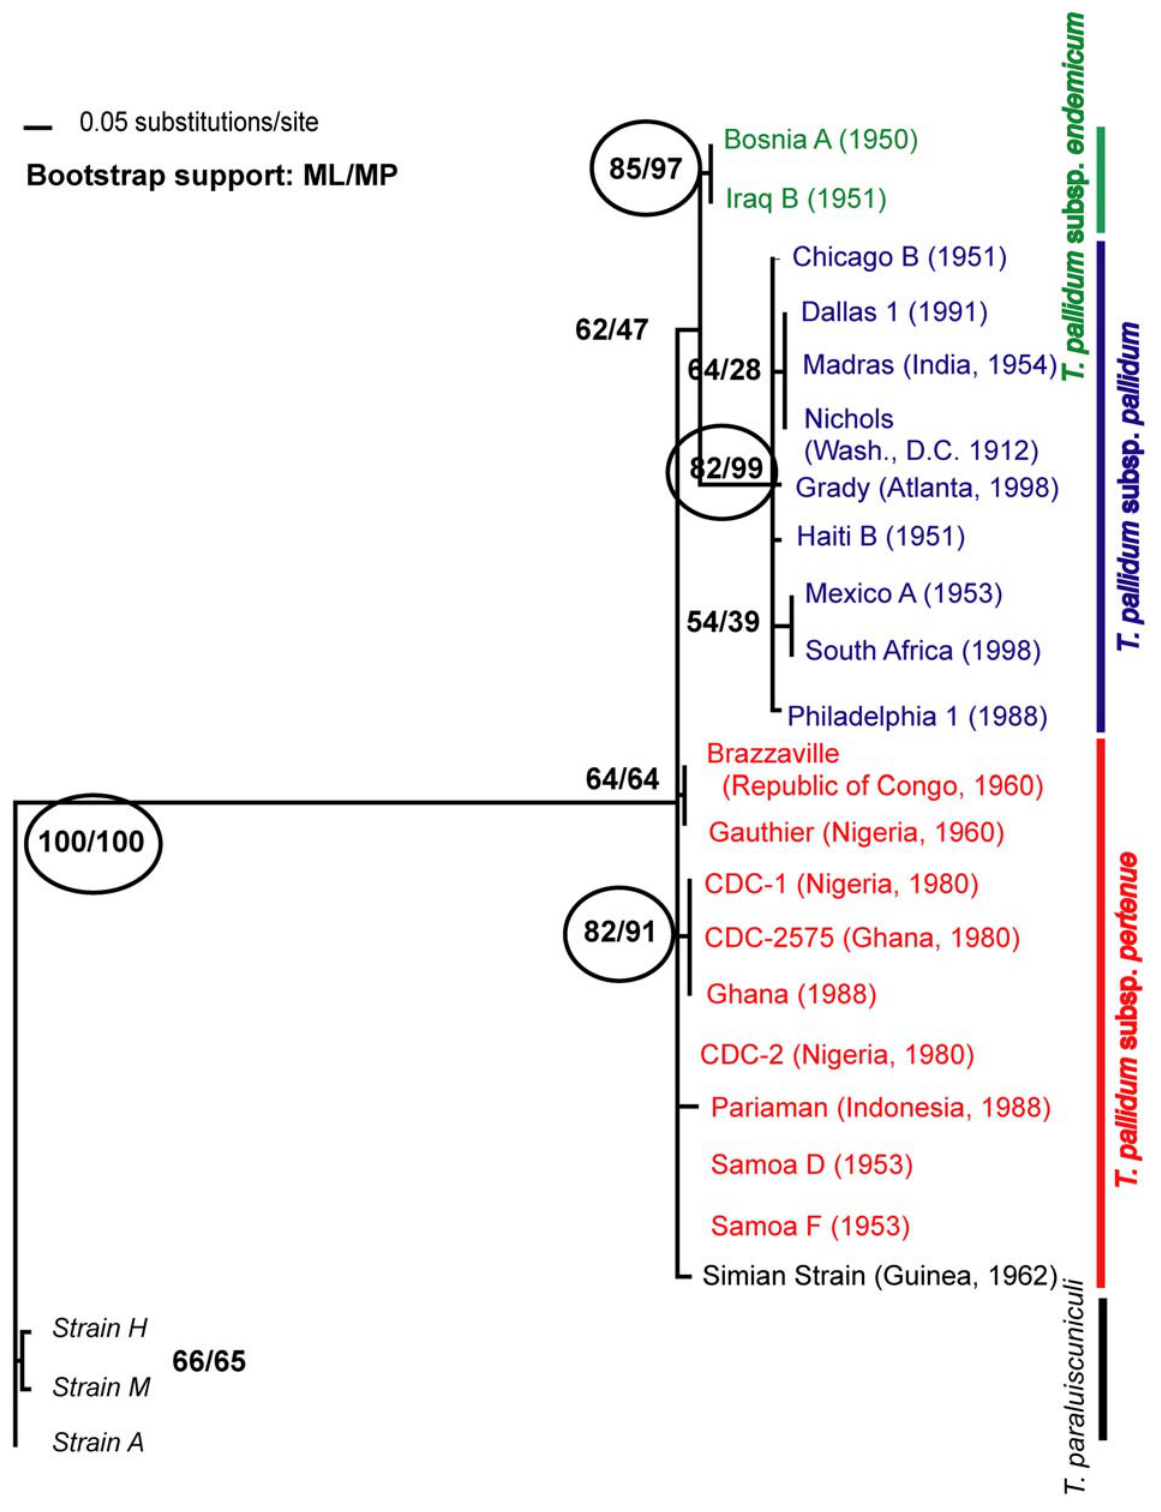
Figure 3. A phylogenetic tree depicting the relationships between the T.pallidum subspecies. This maximum likelihood tree is based on 20 polymorphic regions in the T. pallidum genome. Bootstrap support was estimated with 1,000 replicates in order to assess confidence at branching points and are shown within circles where values are high ( . 90%). Bootstrap support values for both maximum likelihood and maximum parsimony trees are shown, in that order.